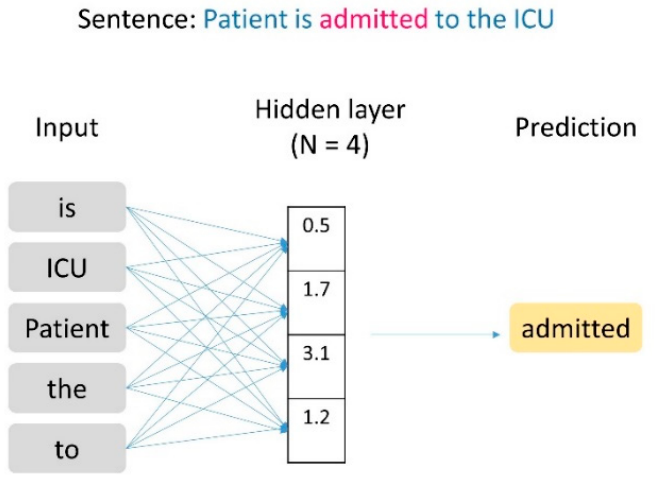
Figure 1. Word2vec embedding model.